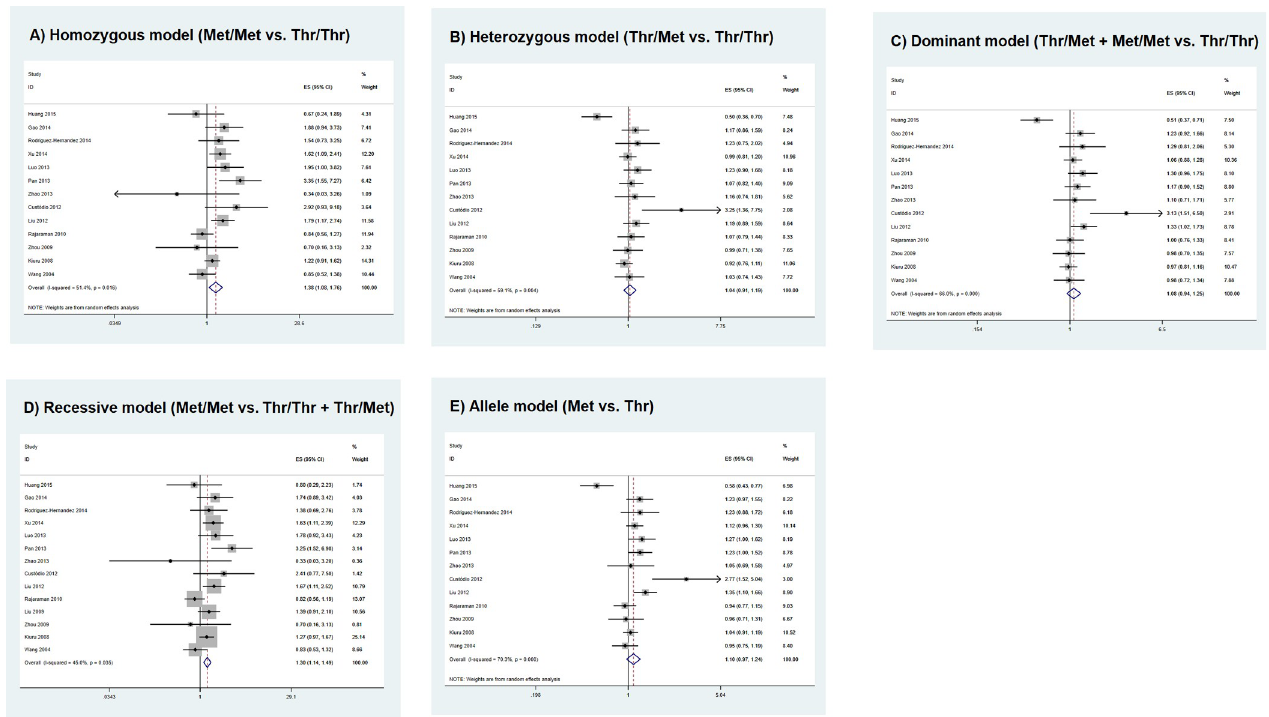
Fig 2. Forest plots of the association between XRCC3 p.Thr241Met polymorphism and glioma risk.